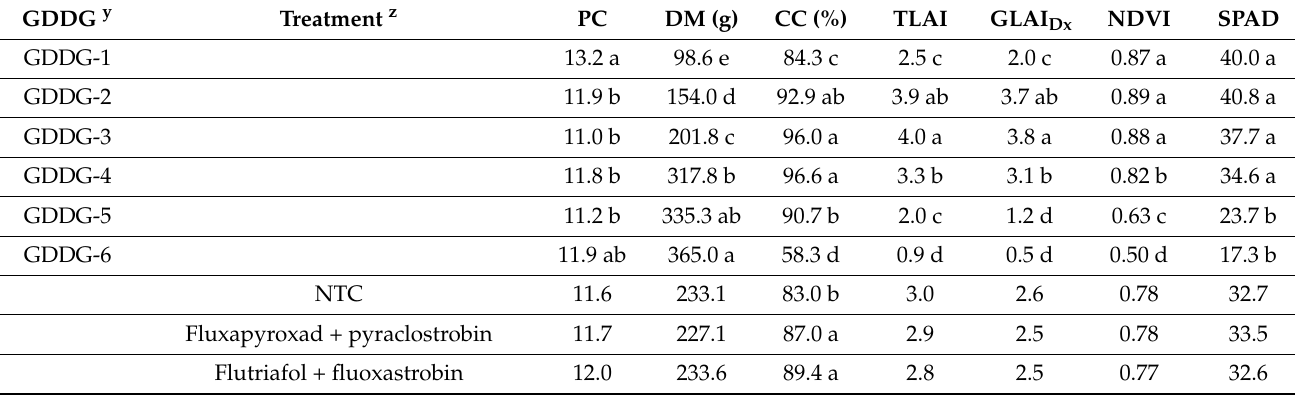
Table 5. Least square means x of the plant count (PC), dry matter (DM), canopy cover (CC), total leaf area index (TLAI), green leaf area index with disease severity removed, normalized difference vegetation index (NDVI), and soil plant analysis development (SPAD) readings recorded in field experiments conducted in in Kanawha and Lewis County Iowa in 2018 and 2019.